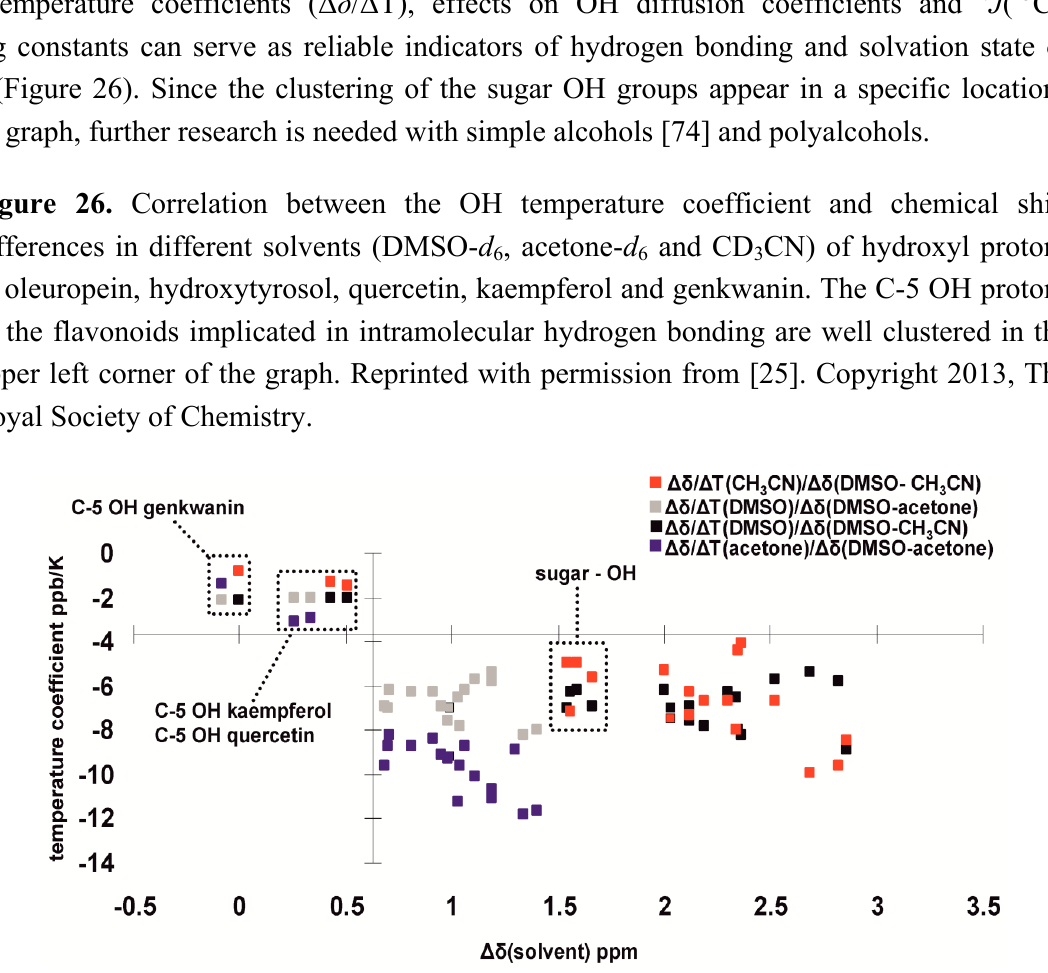
, acetone- d and CD CN) of hydroxyl protons 6 6 3